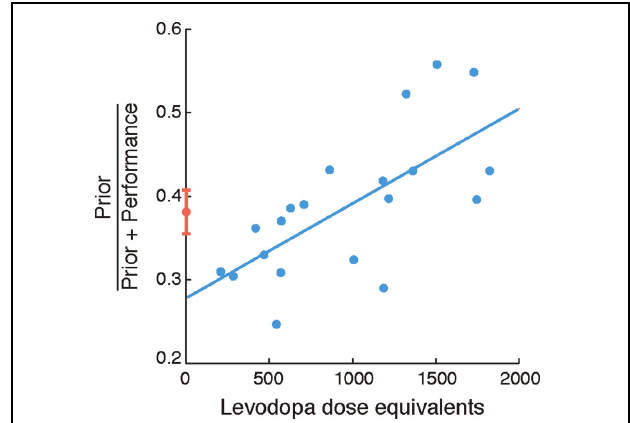
FIGURE 3 | Self priors versus levodopa dose equivalent in patients with Parkinson’s disease (PD). Normalized Self priors plotted against levodopa dose equivalents in patients (blue circles). The blue line indicates a linear regression for illustration purposes. Controls’ data are plotted for reference (orange circle and error bars, indicating control group mean and standard error of the mean,